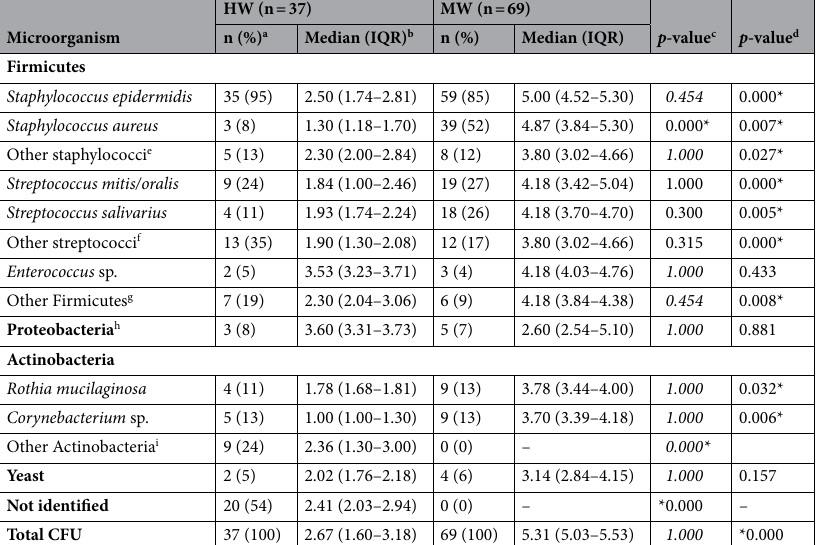
Table 3. Microbiological counts (log 10 CFU/mL) using culture-dependent analysis of milk samples from healthy women (HW) and mastitis cases (MW) where growth was detected (n = 106). IQR interquartile range, CFU colony-forming units. *Statistically significant difference, p < 0.05. a n (%): number (percentage) of samples in which the microorganism was detected (relative frequency of detection). b All data expressed as